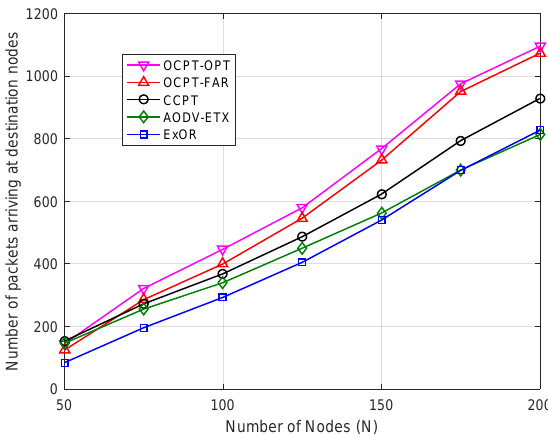
Figure 4. Number of packets successfully arriving at the destinations vs. number of nodes with different schemes under the random V s and V d .